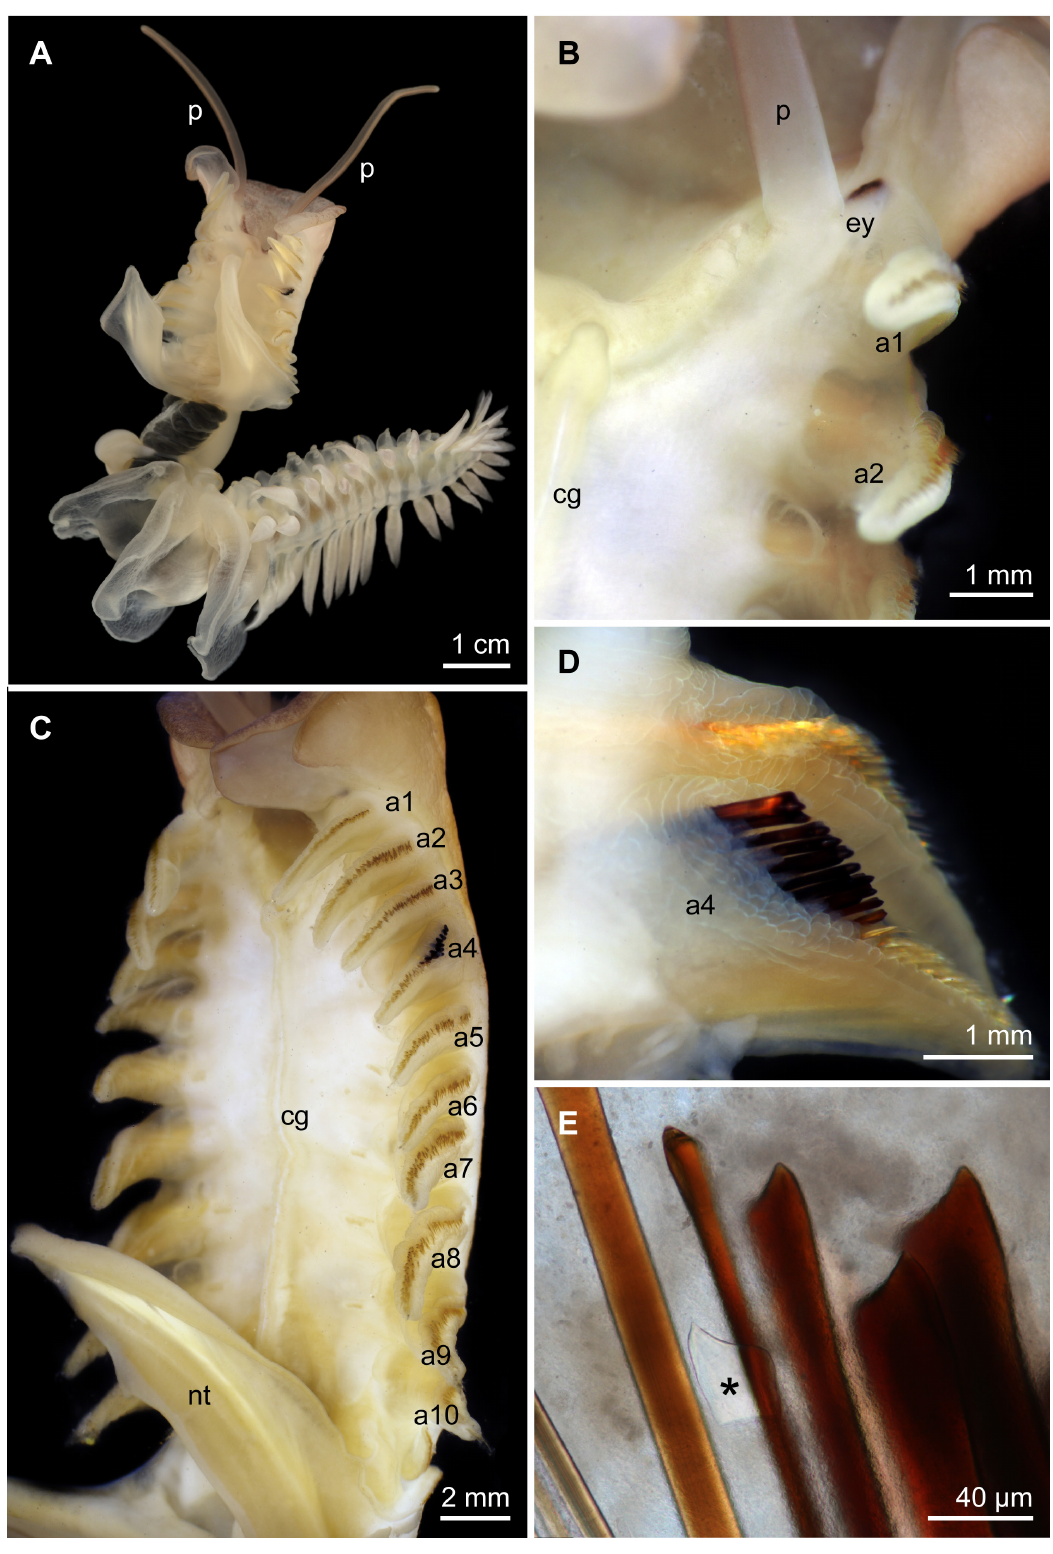
Fig. 2. Chaetopterus dewysee sp. nov. A . Habitus of a paratype (SIO-BIC A11653). B – C . Anterior region A, chaetigers are numbered a1–10. D – E . Details of chaetiger a4 cutting chaetae; * marks a developing cutting chaeta. p = palps, ey = eyes, cg = ciliated groove, nt =